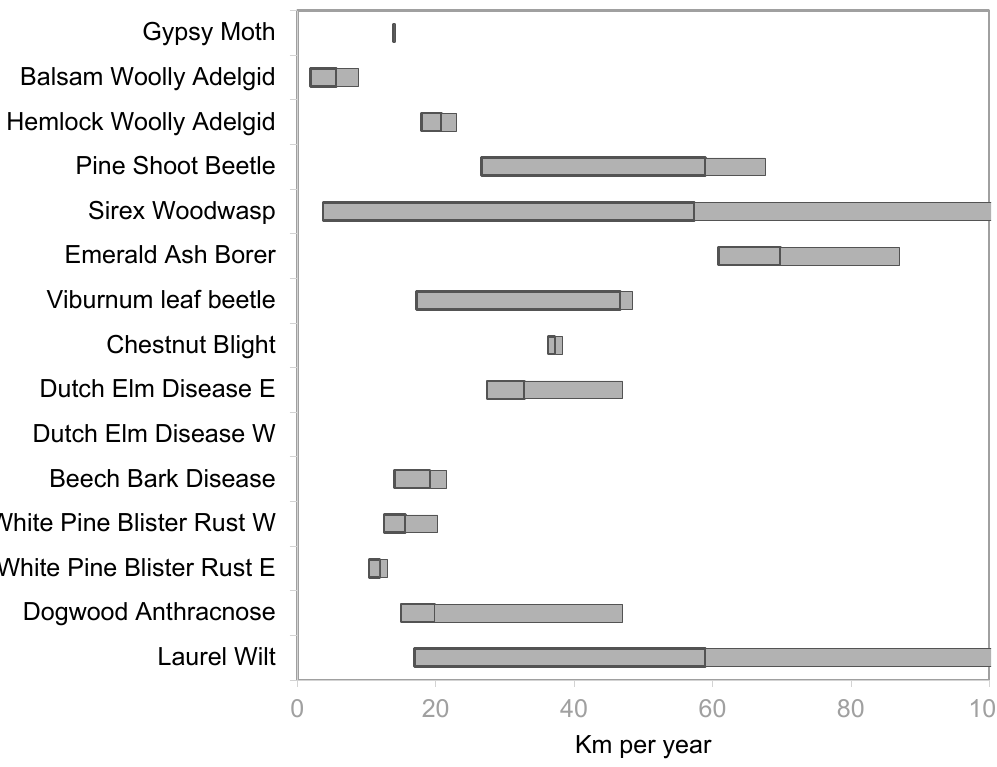
Figure 2. Center lines of boxes are the estimates for unconstrained rate of spread with 90% confidence intervals in gray. The eastern and western infections of Dutch Elm Disease (DED) and White Pine Blister Rust (WPBR) were analyzed separately. No confidence interval is available for the western subset of DED.